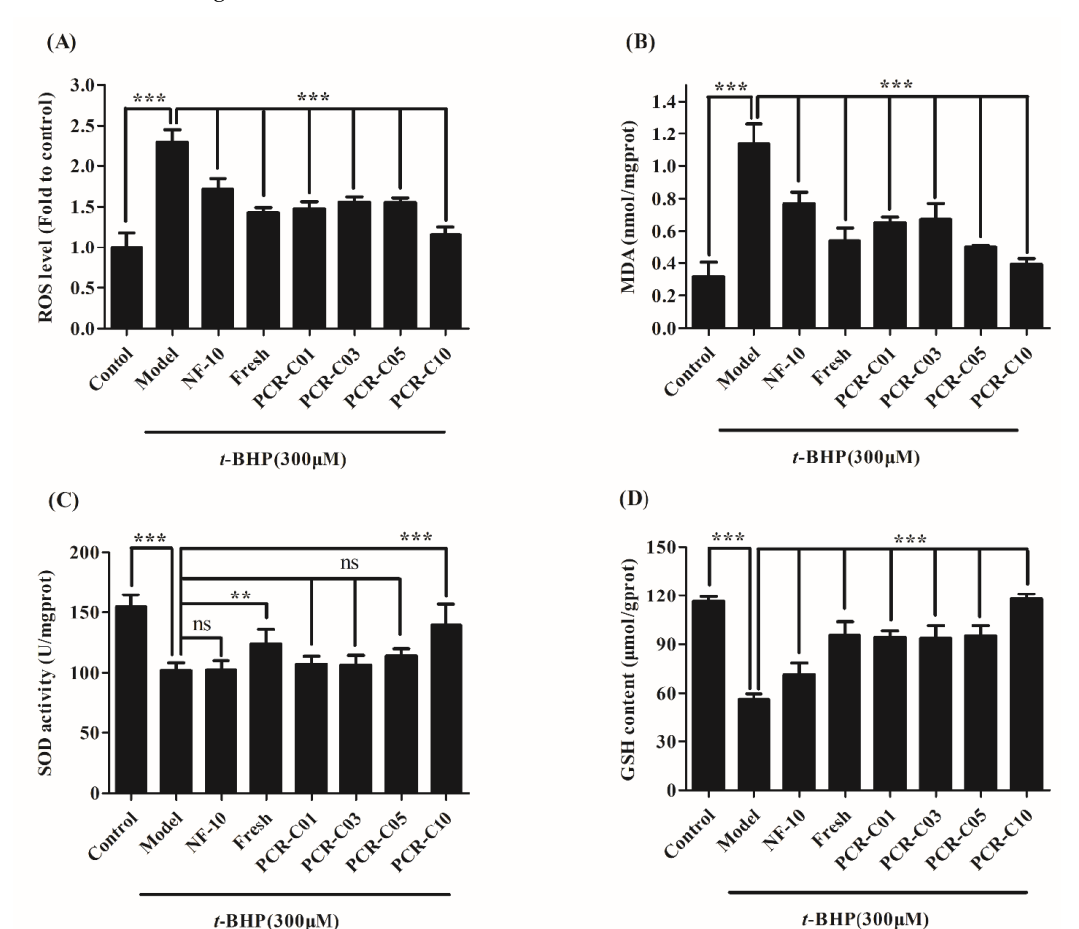
Figure 6. Effect of PCR-C of different storage periods, Fresh and NF-10 on t -BHP-induced ROS ( A ), and MDA ( B ) generation and reduced SOD ( C ) and GSH ( D ) depletion. ( A ) HepG2 cells were pretreated with 50 µ g/mL NF-10, Fresh, PCR-C01, PCR-C03, PCR-C05, and PCR-C10 for 24 h, then incubated with DCFH-DA for 30 min at 37 ◦ C, then with t -BHP (300 µ M) for 1.5 h. ROS levels were determined by a microplate fluorimeter. ( B – D ) HepG2 cells were pretreated with 50 µ g/mL NF-10, Fresh, PCR-C01, PCR-C03, PCR-C05, and PCR-C10 for 24h, and then incubated with t -BHP (300 µ M) for 3 h. MDA, SOD activity, and GSH content were determined using MDA, T-SOD and GSH assay kit, respectively. Results are presented as mean ± SD, n = 6, ns means no significant difference. ** p < 0.01, *** p < 0.001 vs. control